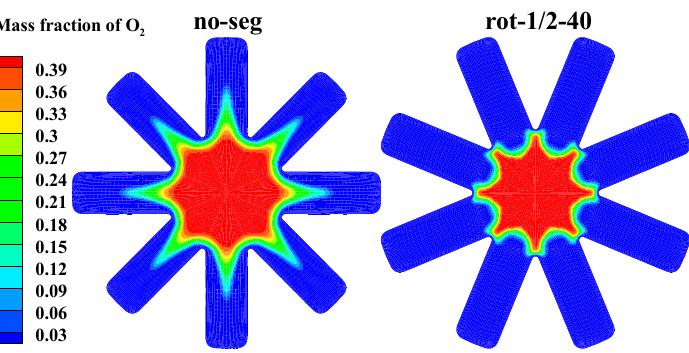
Figure 19. Temperature comparison of the central cross sections of aft-section grain port.